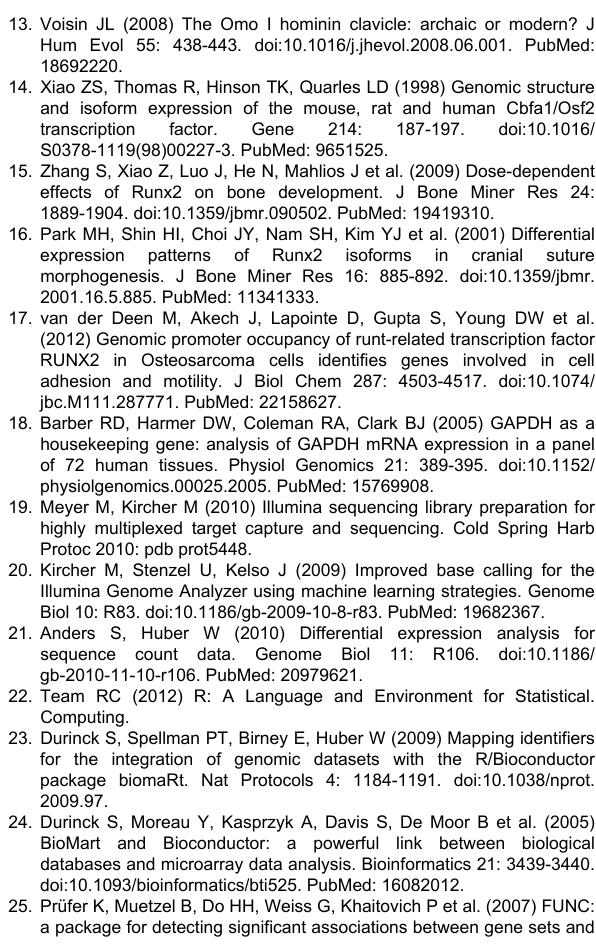
S7. Culture conditions, transfection kits, transfection programs applied for each cell line. Cell Line Nucleofector™ Kits: V (VVCA-1003), L (VCA-1005), T (VCA-1002), R (VCA-1001), Mammalian Fibroblast (VPI-1002). Invitrogen media and supplements: A-MEM (12492-013),